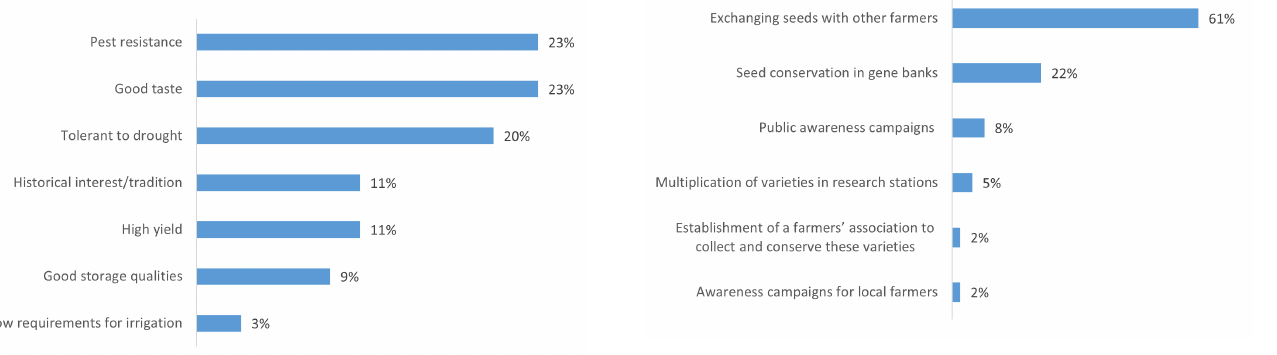
Figure 3. Reasons for the continued cultivation of crop landraces in NW Syria (based on the responses of the 75 interviewees and participants in the 25 FGs).